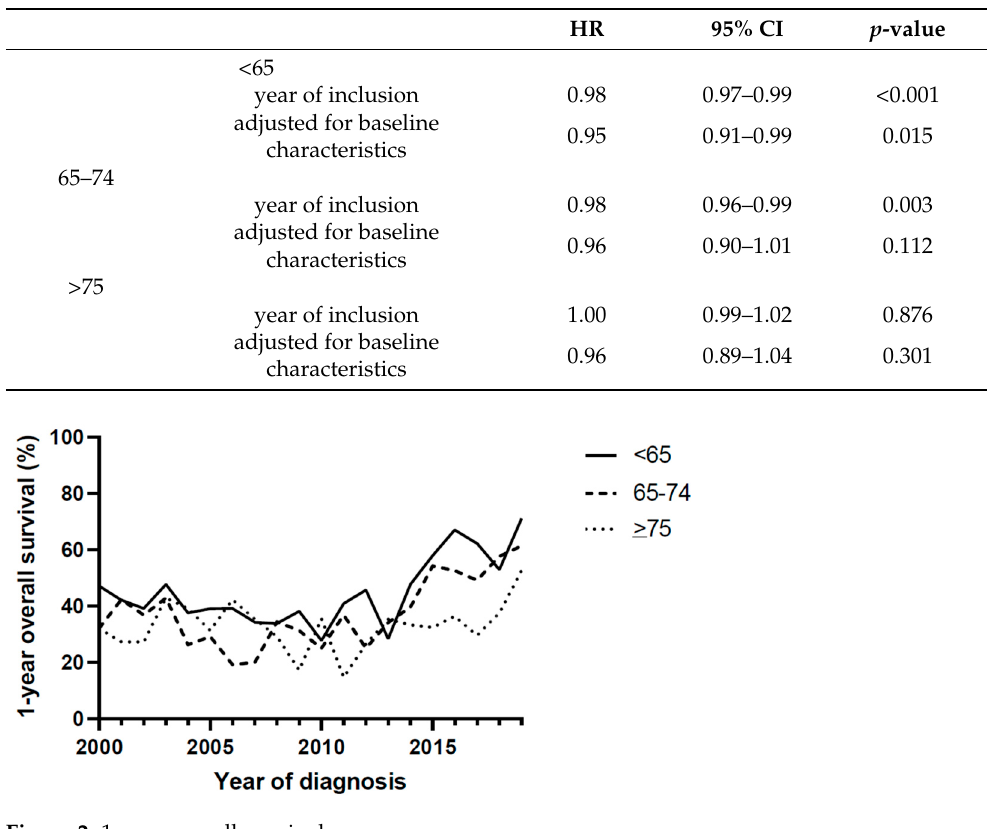
Figure 2. 1-year overall